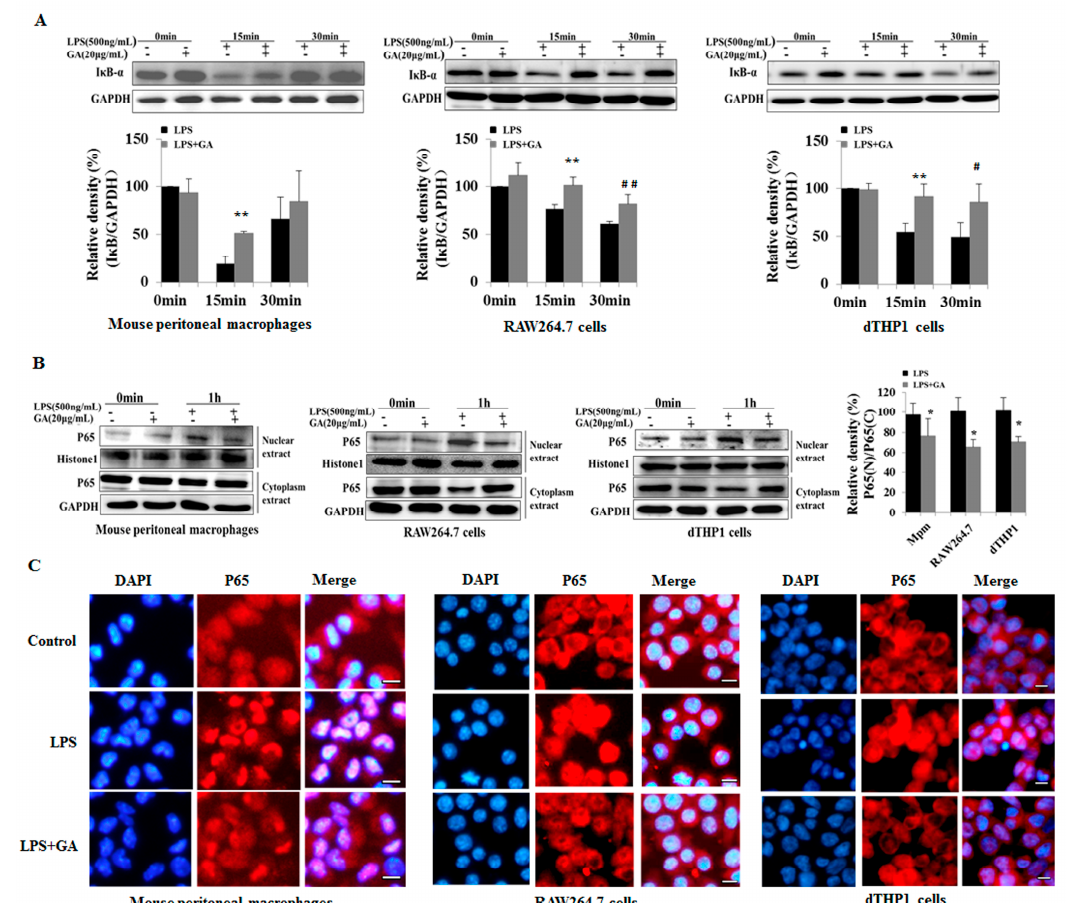
Figure 3. GA suppresses LPS-induced activation of NF- κ B signaling. ( A ) Effects of GA on degradation of I κ B. Mouse peritoneal macrophages ( left ), RAW264.7 cells ( middle ), and dTHP-1 cells ( right ) were pre-treated with 20 μ g/mL GA for 1 h and then stimulated with LPS (500 ng/mL) for 0, 15, and 30 min. Total cellular lysates were prepared and analyzed for I κ B by Western blotting. The histograms below the blots show the relative density ratios (fold changes) measured by Image J. Values are presented as means ± SD of three independent experiments. ** p < 0.01 versus the LPS group at 15 min; # p < 0.05, ## p < 0.01 versus the LPS group at 30 min. ( B , C ) Effects of GA on nuclear translocation of p65; ( B ) mouse peritoneal macrophages ( left ), RAW264.7 cells ( middle ), and dTHP-1 cells ( right ) were pre-treated with 20 μ g/mL GA for 1 h and then stimulated with LPS (500 ng/mL) for 1 h. Nuclear and cytosolic extracts were isolated, and the levels of p65 in each fraction were determined by Western blotting. Histone 1 was detected as a nuclear internal control, and GAPDH was used as a cytosolic internal control. The histogram shows relative density ratios (fold changes) measured by Image J. Values are presented as means ± SD of three independent experiments * p < 0.01 versus the LPS group. Mpm, mouse peritoneal macrophages; ( C ) Mouse peritoneal macrophages ( left ), RAW264.7 cells ( middle ), and dTHP-1 cells ( right ) were treated as in ( B ). The nuclear translocation of p65 was determined by immunofluorescence staining. DAPI-stained nuclei are indicated by blue fluorescence. Nuclear and cytosolic p65 are indicated by red fluorescence. Nuclei appear purple in merged images. Bar, 50 μ m. NF- κ B, nuclear factor kappa-B; I κ B, inhibitor of NF- κ B; DAPI, 2-(4-Amidinophenyl)-6-indolecarbamidine dihydrochloride.